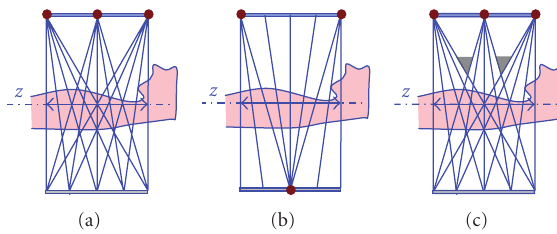
Figure 2: Multi-axial acquisition geometries with 3 longitudinal acquisitions (source positions marked as red dots): (a) fully opened collimation, (b) full-scan mode with semi-closed collimation (central source is shown in opposite side.), and (c) half-scan mode with fully opened